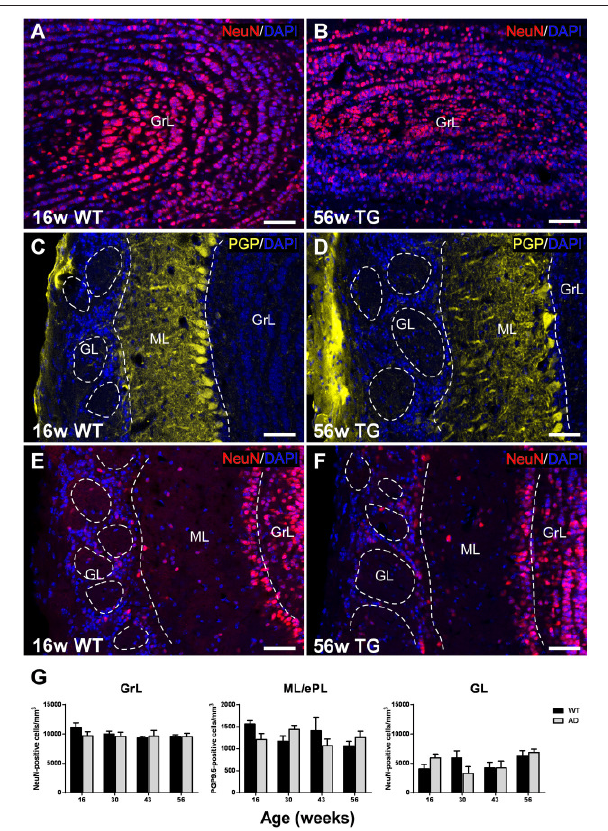
FIGURE 1 | Analysis of neurogenesis in the olfactory bulb by quantification of bromodeoxyuridine-labeled cells. (A,B) , Nissl staining of a mouse main olfactory bulb showing all cell layers where analysis has been carried out. (C–F) , examples of bromodeoxyuridine-positive cells at different ages, in different layers, and in wild type and transgenic animals illustrating statistical analysis. (G) , graphics illustrating the estimation of bromodeoxyuridine-positive cells/mm 3 in control and transgenic animals in different layers with aging. Calibration bar, 50 µ m. White arrows point to labeled cells. * P < 0.05 .